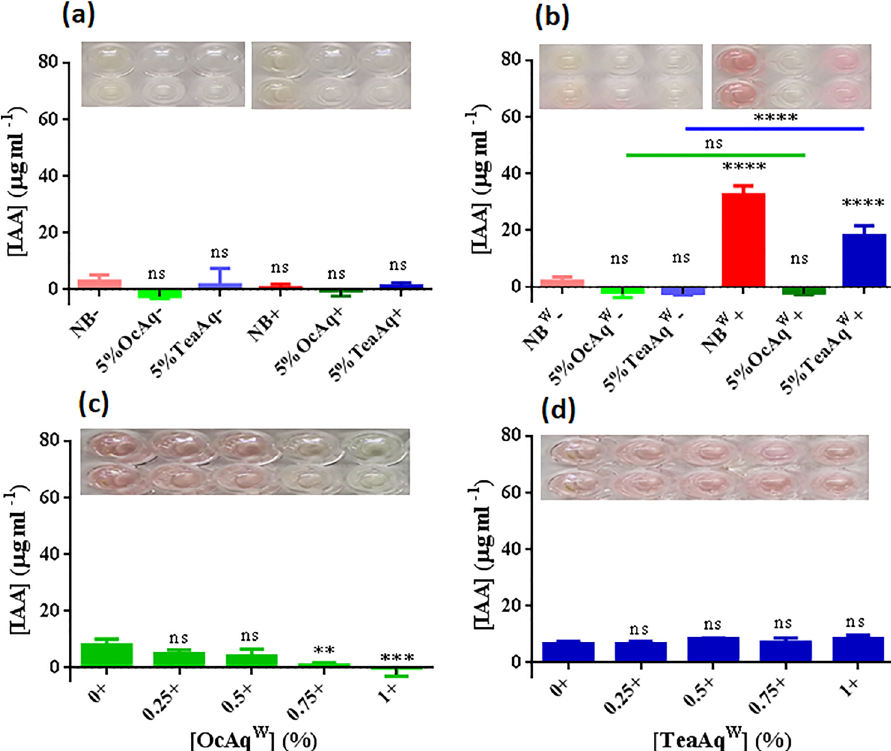
Figure 6. Influence of the direct contact of 1-octanol (OcAq) and aqueous tea extract (TeaAq) on IAA production in Pseudomonas sp. NEEL19, cultured in the presence/absence of 0.1% (w/v) Trp. ( a ) and ( b ) respectively show IAA production in the absence and presence of 0.1% (w/v) Trp when supplied with 5% (v/v) 1-octanol (OcAq) and 5% (v/v) aqueous tea extract (TeaAq). NB and NB W , full-strength nutrient broth (Himedia) without and with 0.1% (w/v) Trp, respectively. + , cells present; –, cells absent. Cell-free NB and NB W were used as controls in ( a ) and ( b ), respectively. ( c ) and ( d ) show IAA production at low concentrations (< 1%) of OcAq and TeaAq present in DSMZ 125* with 0.1% (w/v) Trp supplement, respectively. BM W without OcAq and TeaAq supplement were used as controls in ( c ) and ( d ), respectively. Microplate sections (insert, a–d ) obtained in this study represent chromogenic reactions of respective IAA assay. Error bar, mean (n = 4) ± s.d. ** P < 0.05, *** P < 0.01, **** P < 0.0001; ns,